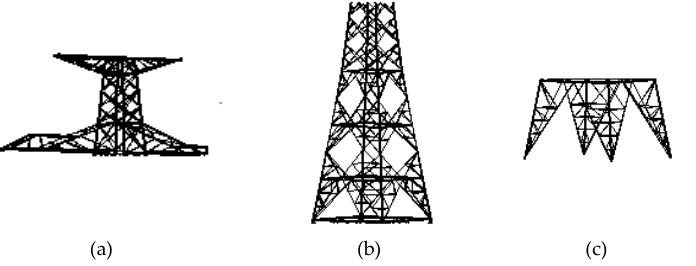
Figure 1. Structure map of transmission tower. (a) tower head; (b) tower body; (c) tower foot